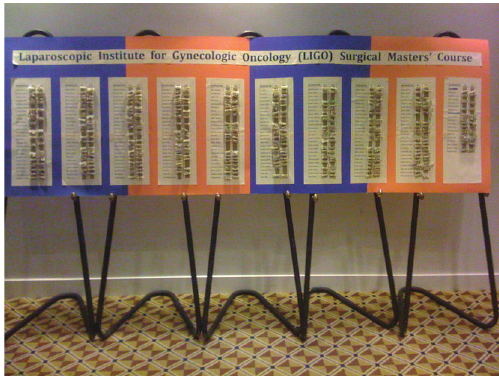
Figure 3: The first Holiotomy board attested to completion of the Holiotomy challenge, and revealed participation and completion by 88% of the 225